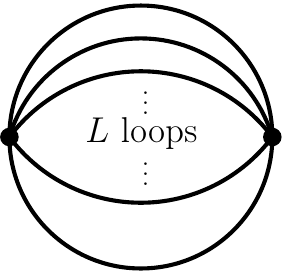
Figure 1 . L -loop two-point massive tadpole. Each line corresponds to the propagator with arbi- trary mass and